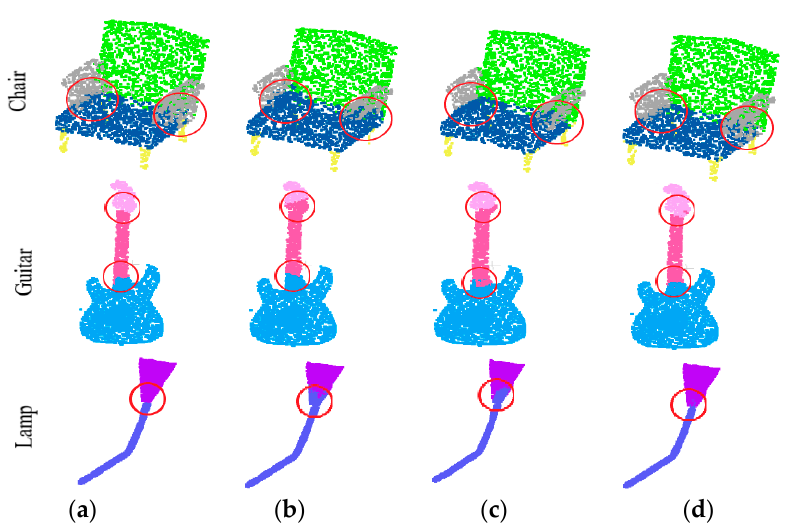
Figure 11. Part segmentation results of three models in ShapeNet dataset. ( a ) Ground Truth. ( b )PointNet++. ( c ) Dynamic Graph Convolutional Neural Network (DGCNN). ( d ) the proposed DNet.